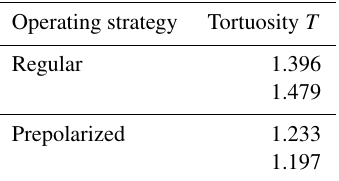
Table 2. Results of the MATLAB ® soot structure evaluation using Dijkstra’s algorithm to spot the closed soot paths as visualized in Fig.